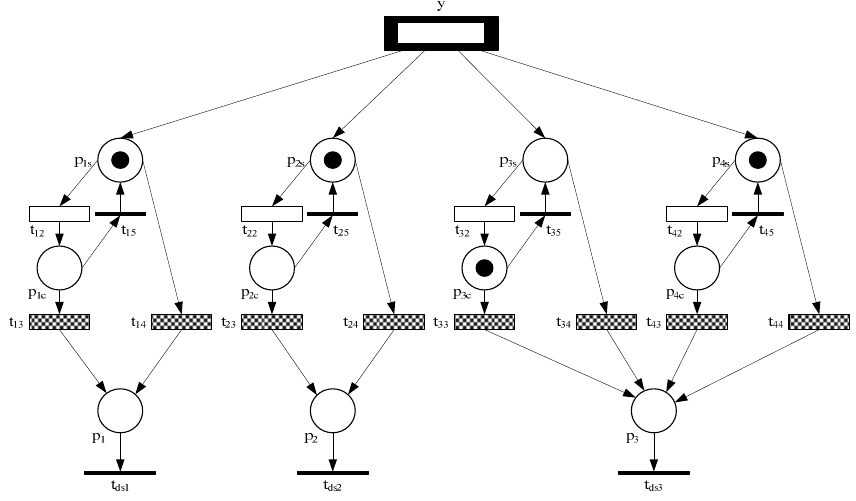
Figure 7. PN model for a system with four charging tanks and three distillers.